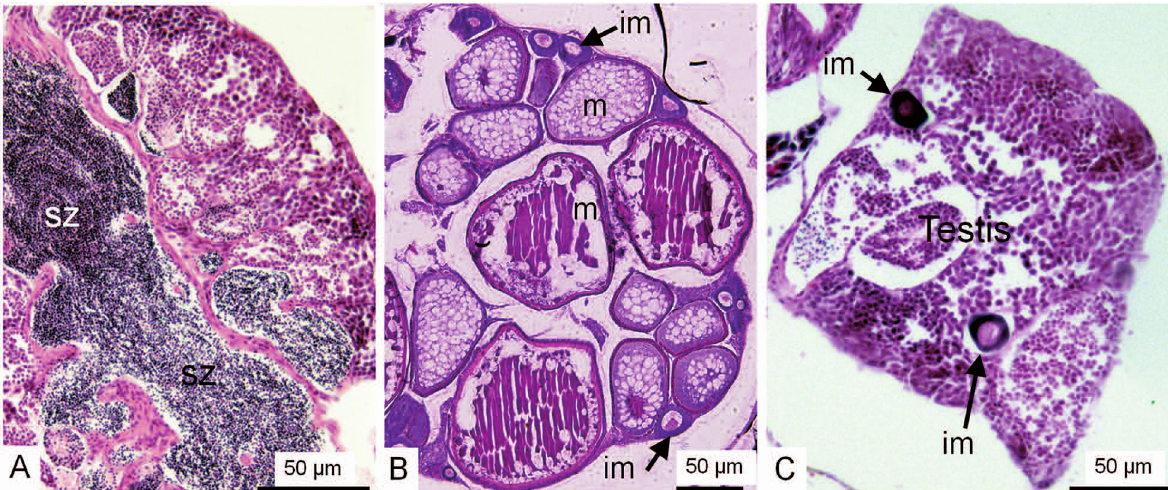
Fig. 5. Histological analysis of gonads from untreated (A) male and (B) female of Thai medaka, Oryzias minutillus ; (C) Oocyte development in the testicular tissue of a male exposed to 1 µg · mL –1 pendimethalin for 60 days; sz = spermatozoa, m = mature oocyte, im = immature